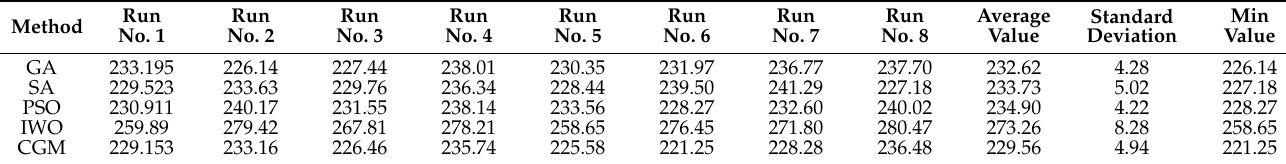
Table 6. Results of several runs of all optimization algorithms on a single configuration for the BoT scheduling problem.